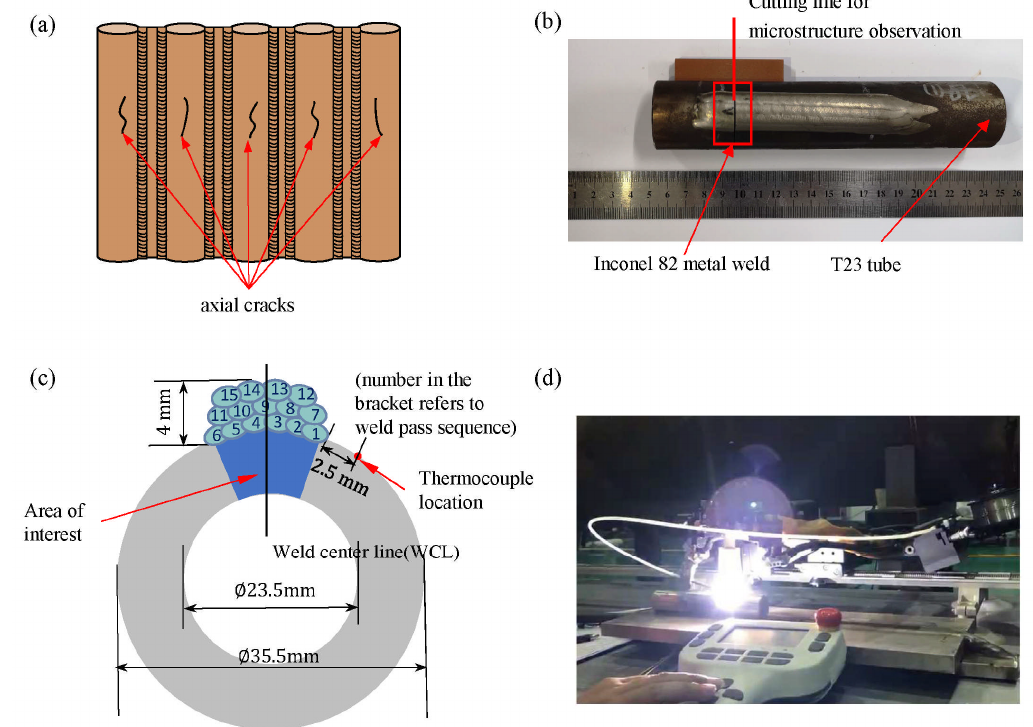
Figure 1. ( a ) Appearance of axial cracks on the outer surface of T23 water-wall tubes; ( b ) appearance of the overlaying sample with 82 Inconel weld metal; ( c ) transverse geometry of the weld overlay joint and layout of the welding pass sequence; and ( d ) manufacturing process of the overlaying sample.